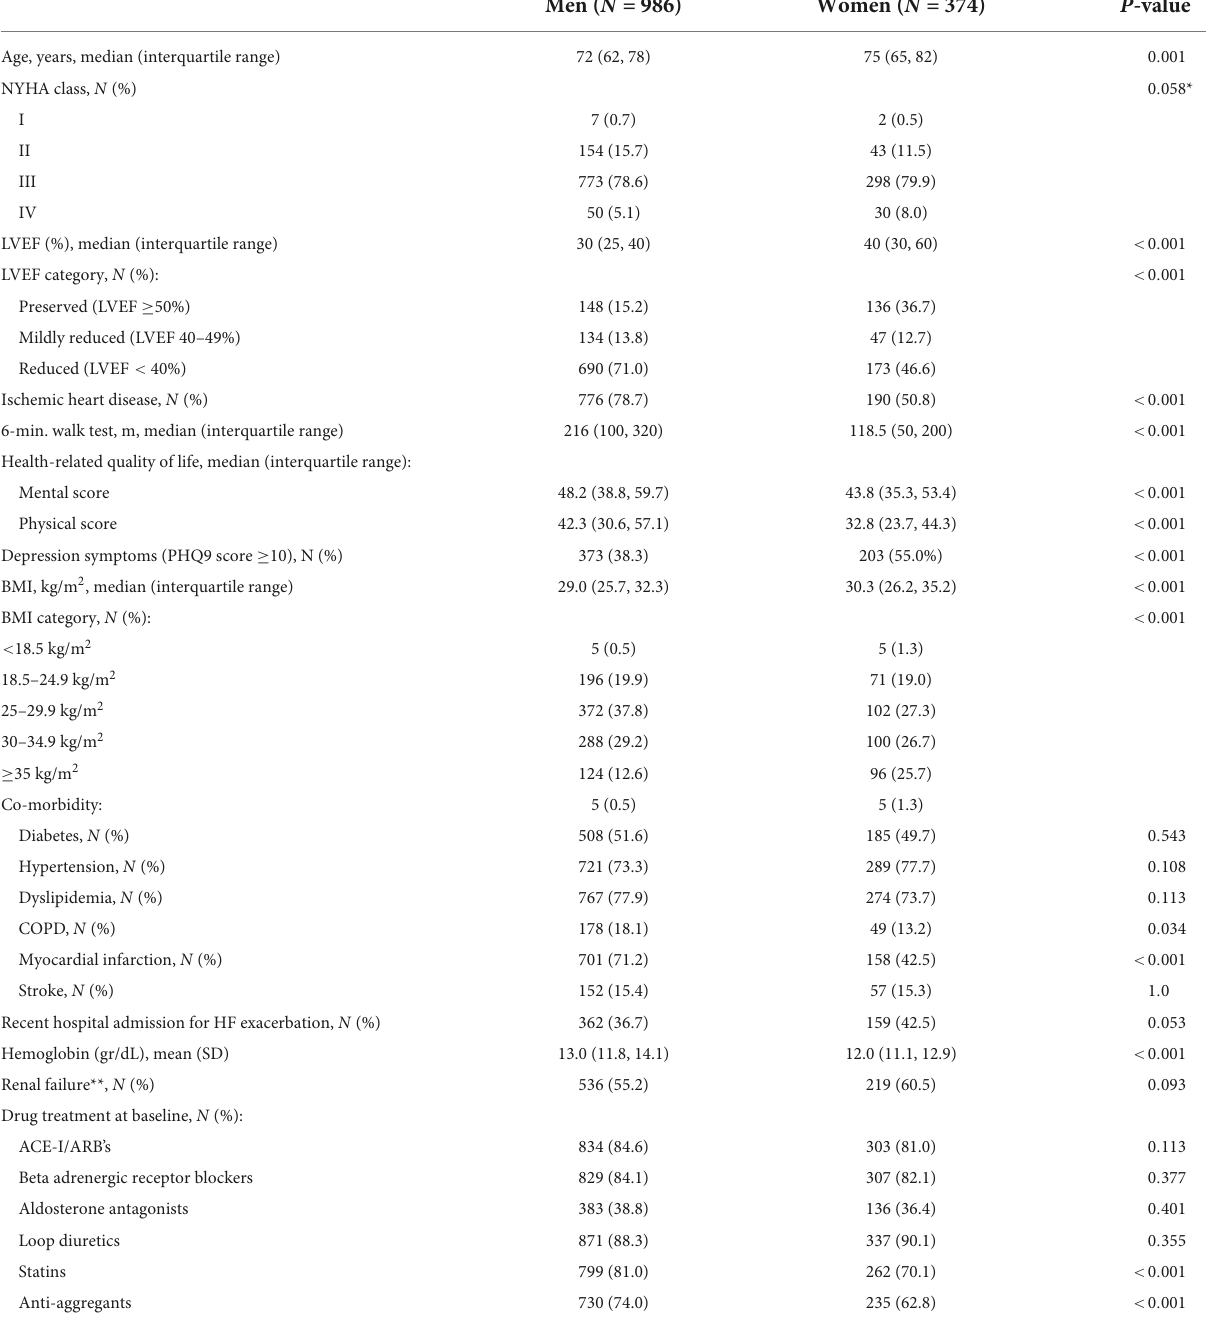
TABLE 1 Baseline patients’ characteristics by